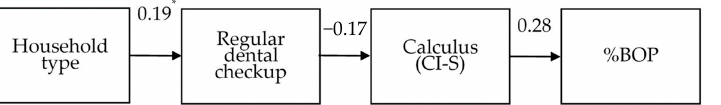
Figure 3. Pathway based on structural equation modeling showing the association between household type, oral health behavior, oral hygiene status, and the percentage of bleeding on probing (%BOP). * Values above single-headed arrows indicate standardized coefficients.